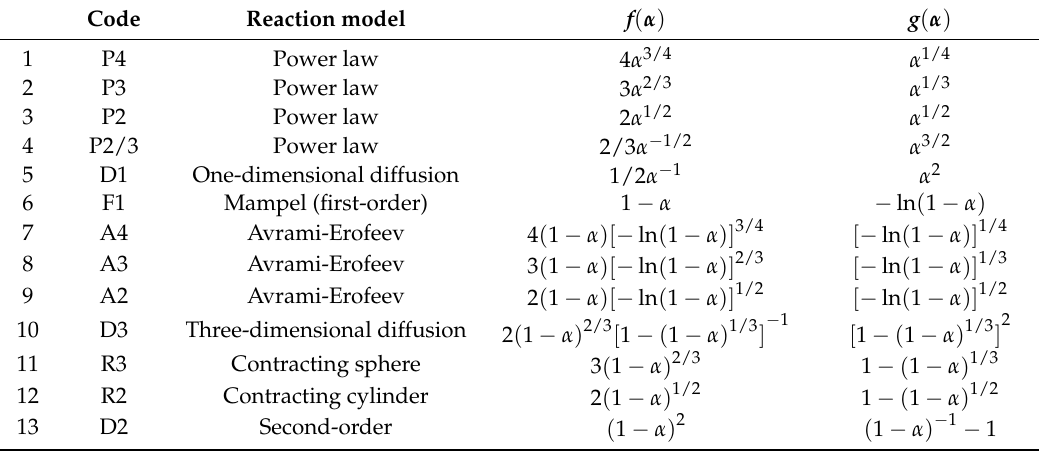
Table 1. Chosen kinetic models to describe thermally activated processes [24].